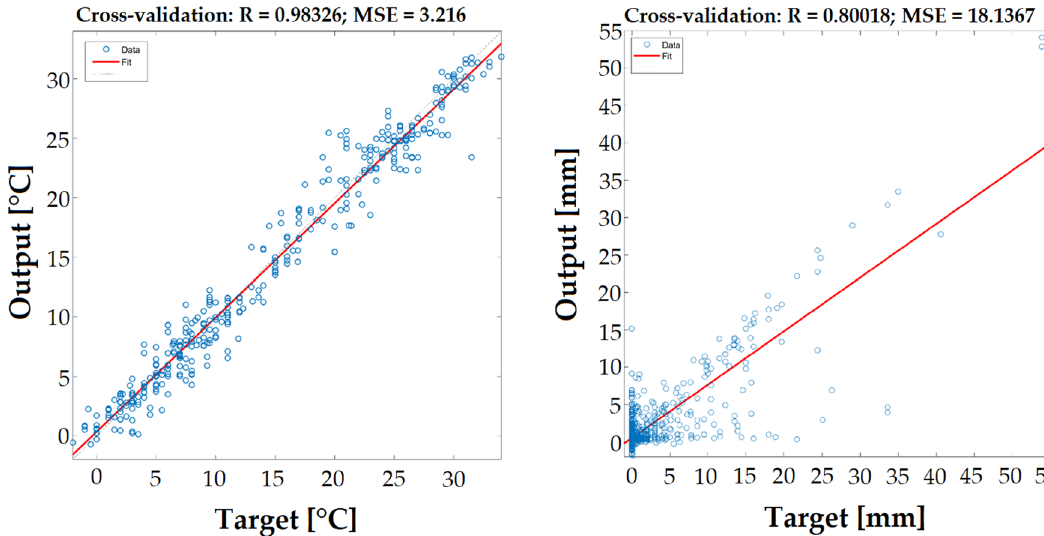
Figure 4. Scatter plot with the Pearsons correlation coefficient R and MSE of hourly temperature prediction in the left part and daily precipitation prediction in the right part.